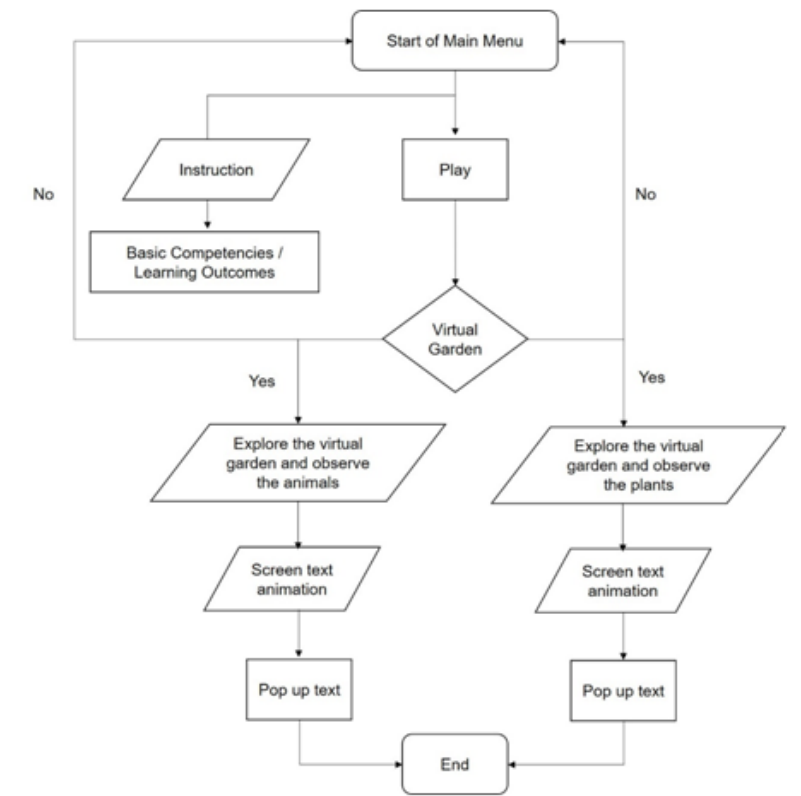
Figure 1. Workflow of Interactive Virtual Garden